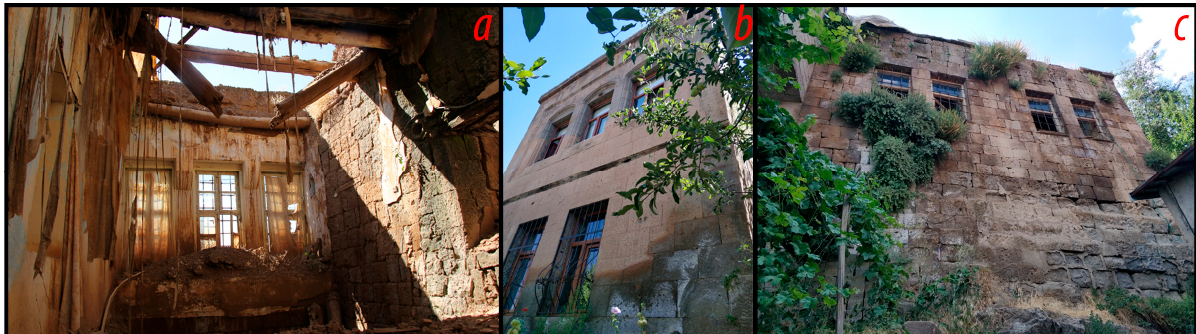
Figure 4. Some of the observed damages to the structures: ( a ) Collapsed roof, ( b ) Moisture and li- chen formation, ( c ) Surface loss, color change,